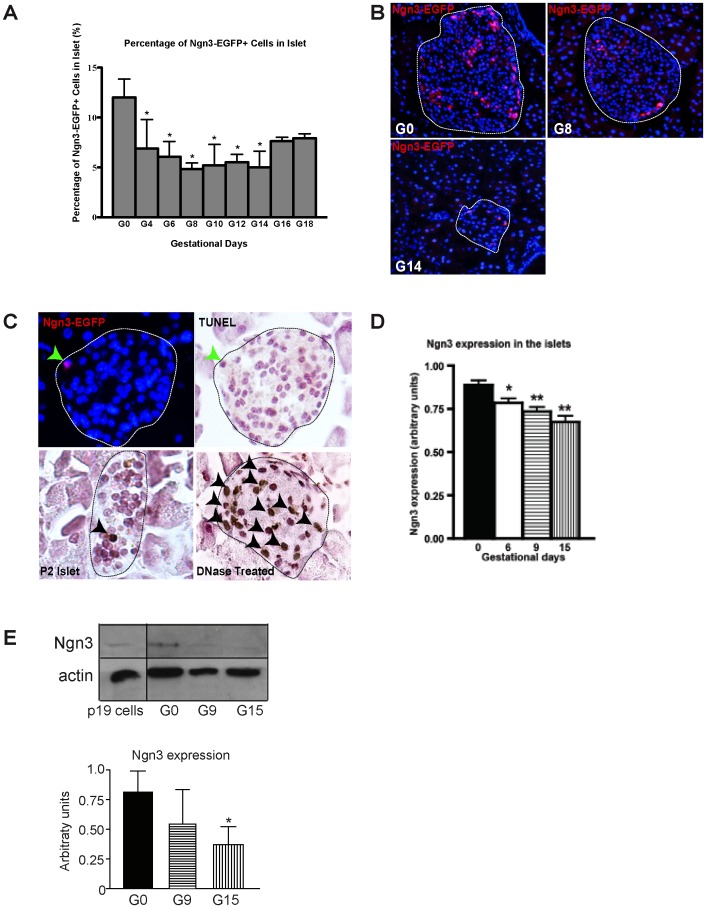
Ngn3-positive cells in pancreatic islets during pregnancy.
A) Percentage of cells in the pancreatic islets of Ngn3:EGFP mice stained positive for EGFP (therefore expressing Ngn3, these cells will be denoted as Ngn3-EGFP+ in all images) but negative for endocrine hormones drops during pregnancy. The number of Ngn3-EGFP+ cells was expressed as a percentage of all the cells in the islets. Islets (outlined in white) were identified by staining for endocrine hormones. At least 10,000 cells were counted from each mouse. N = 3–4 separate mice were sampled at each gestational stage. “*”: p<0.05 in comparison to the non-pregnant (G0) mice by student’s t-test. B) A representative image of an islet at G0, G8 and G14. C) A representative image of TUNEL staining of an islet (outlined) at G6. Islets at postnatal day 2 (P2) and DNase treated pancreas served as controls. Black arrowheads indicate apoptotic (brown) cells. D) mRNA levels of Ngn3, as measured by qRT PCR in islets isolated from mice on days 0, 6, 9, and 15 of pregnancy expressed as mean ± SEM; N = 6 separate mice at each gestational stage. All expression levels are normalized to that of PGK-1 (phosphoglycerate kinase 1). “*”: p<0.05 and “**”: p<0.01 in comparison to non-pregnant (G0) mice by one-way ANOVA. E) Whole cell lysates were prepared from islets isolated from mice on days 0, 9, and 15 of pregnancy and immunoblotted for Ngn3. The optical density of the Ngn3 band was normalized to that of actin, which was used as the loading control. A representative blot is shown. Results represent mean ± SEM. N = 3–5 mice at each gestational stage from three separate experiments. “*”: p<0.05 in comparison to non-pregnant (G0) mice by one-way ANOVA.